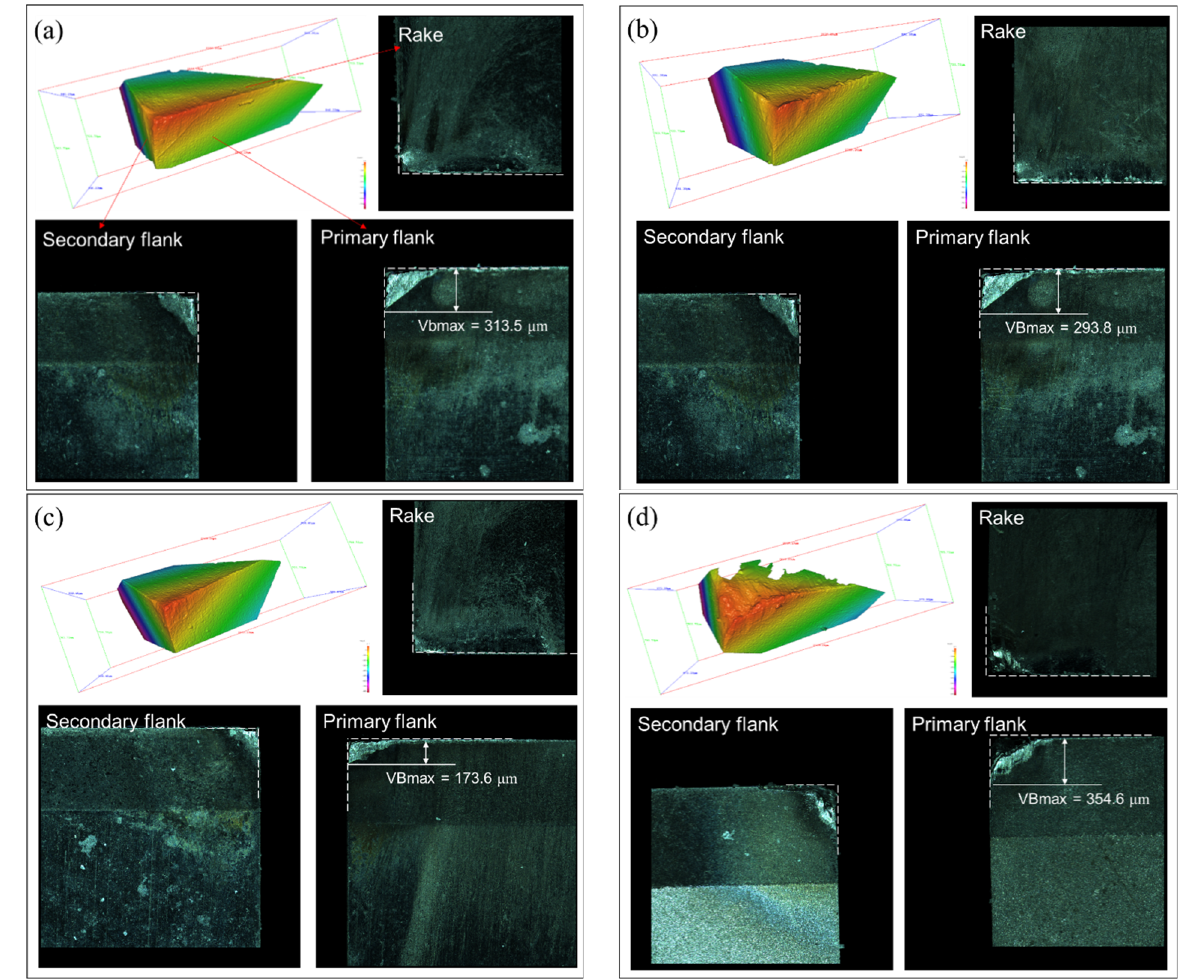
Figure 5. Three-dimensional images of the worn areas of different PCD inserts: ( a ) 002A, ( b ) 002E, ( c ) 302A, and ( d ) 302E.